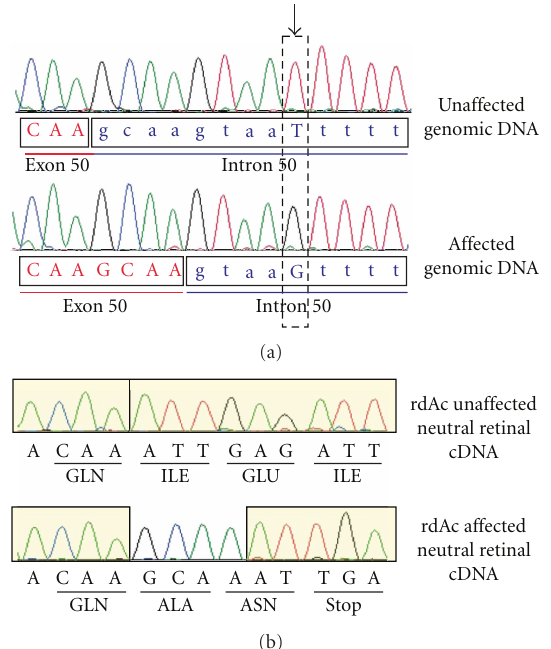
Figure 3: (a) Electropherograms of genomic DNA of CEP290 sequenced in una ff ected and rdAc a ff ected individuals of exon 50/intron 50 junction. Arrow indicates position of SNP in intron 50, which uncovers a canonical GT splice donor site, resulting in alternative splicing in a ff ected individuals. Exon 50 (red letters) and intron 50 (blue letters) nucleotides were identified by cDNA sequence analysis. GenBank Accession No. for feline CEP290 : EF028068. (b) Electropherograms of cDNA for CEP290 3 (cid:2) region of exon 50 generated from neural retinal tissue in a ff ected and una ff ected individuals. Alternative splicing in a ff ected individuals results in a frame shift and introduction of a premature STOP codon. Reproduced with permission from